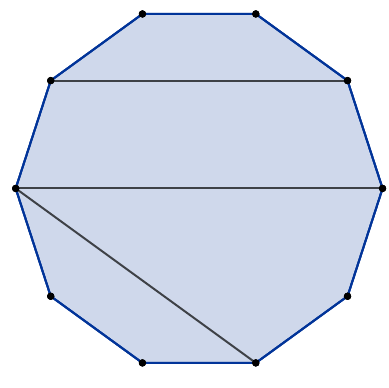
Figure 16 . Accordiohedron for dissection (14 , 47 , 710) .